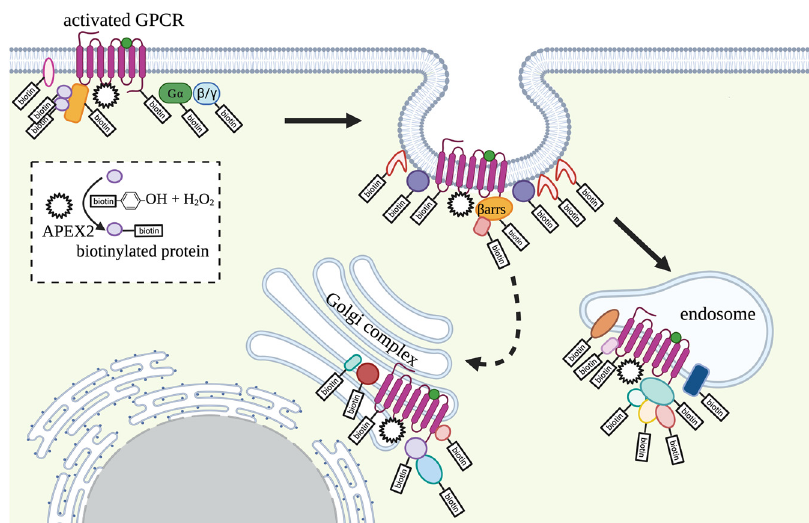
Figure 4. APEX-based PL-MS can capture the spatiotemporal dynamics of a GPCR signaling land- scape. A GPCR fused to APEX2 is expressed in the relevant cell. After the addition of ligand and biotin-phenol, the ligand-bound GPCR-APEX2 can undergo dynamic and ligand-specific membrane trafficking to multiple membrane locations, such as endosome or the Golgi complex, where the receptor can engage with distinct signaling elements and/or sorting machinery. The addition of H 2 O 2 at different time points after agonist stimulation initiates biotin labeling and generates time-resolved snapshots of GPCR signaling networks along the trafficking route. Biotinylated proteins are enriched and analyzed by LC-MS/MS to identify the compositions of the receptor local networks. Figure created with Biorender.com.